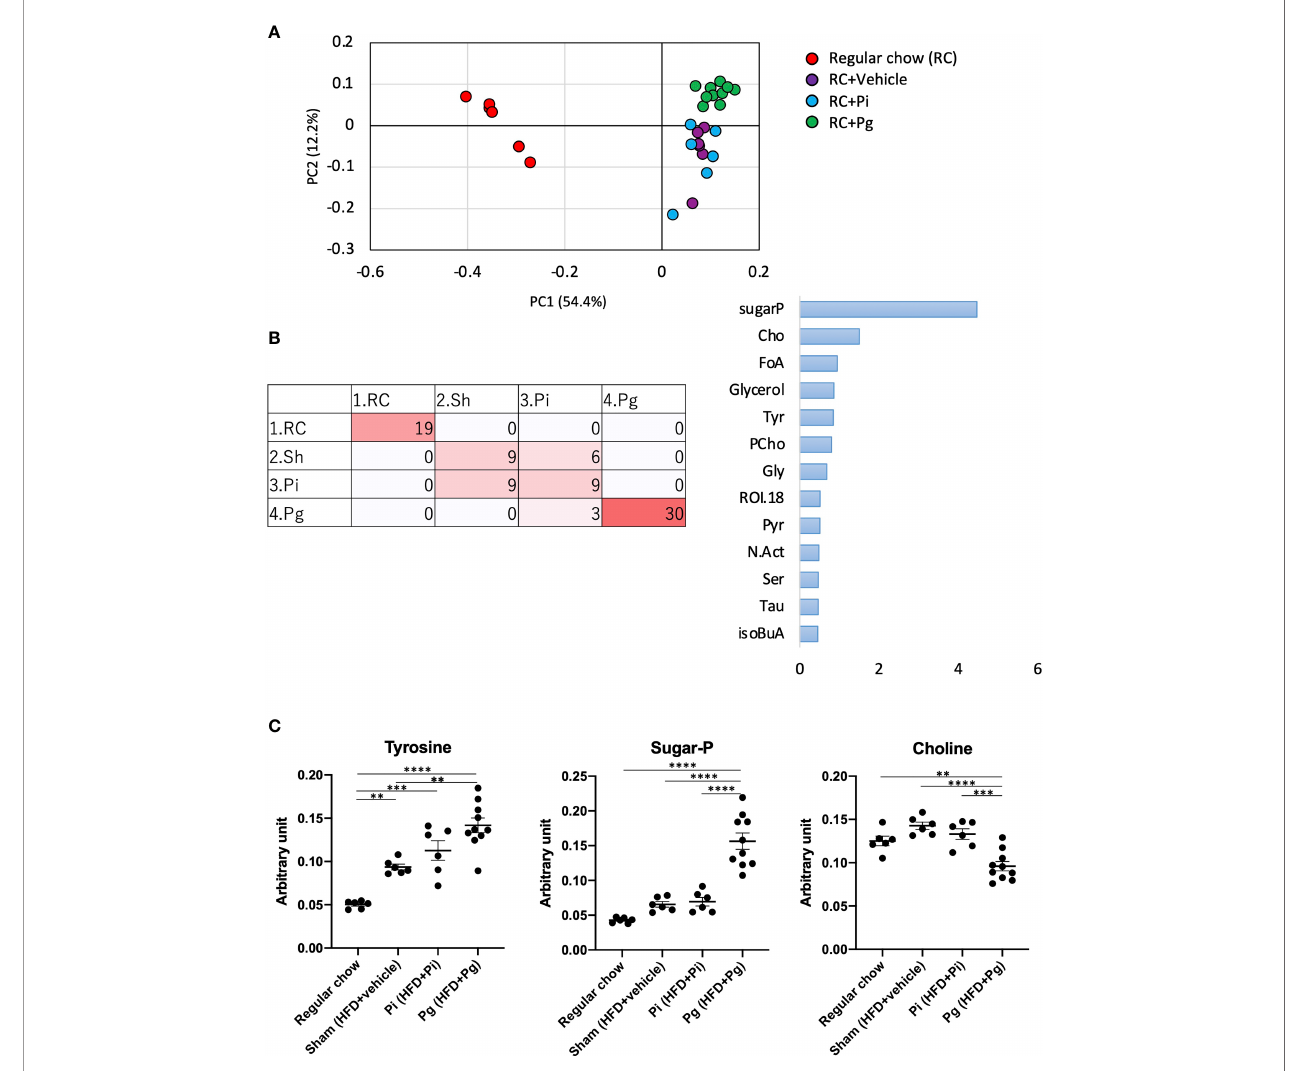
FIGURE 7 | Effect of CDAHFD60 feeding and subsequent bacterial administration on serum metabolites. (A) PCA of serum metabolites in each group. (B) Machine learning (random forest) classi fi cation of each group. Left: confusion matrix (RC, regular chow; Sham, HFD + vehicle; Pi, HFD + Pi; Pg, HFD + Pg). Right: important variables (metabolites) contributing to four classi fi cations. Tyr, tyrosine; CHO, choline; FoA, formate; Gly, glycine; CiA, citrate; GPC, glycerophosphocholine; Ac, acetate; ROI, region of interest. (C) Compounds that differed in abundance among groups (n=6-10/group). Data are expressed as the mean ± standard error of the mean (SEM). P values were calculated using one-way ANOVA with Tukey ’ s multiple comparisons test. ** P <0.005, *** P <0.001, **** P